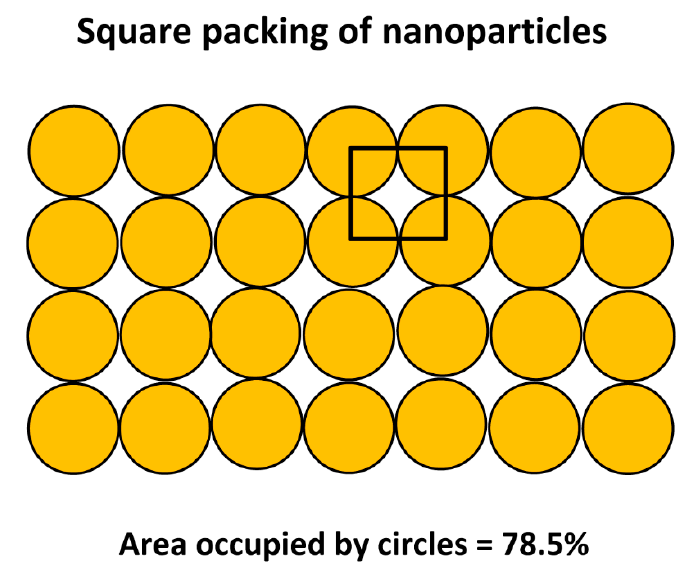
Fluids 2019 , 4 , x FOR PEER REVIEW Figure 11. Square packing of nanoparticles. Figure 11. Square packing of nanoparticles.